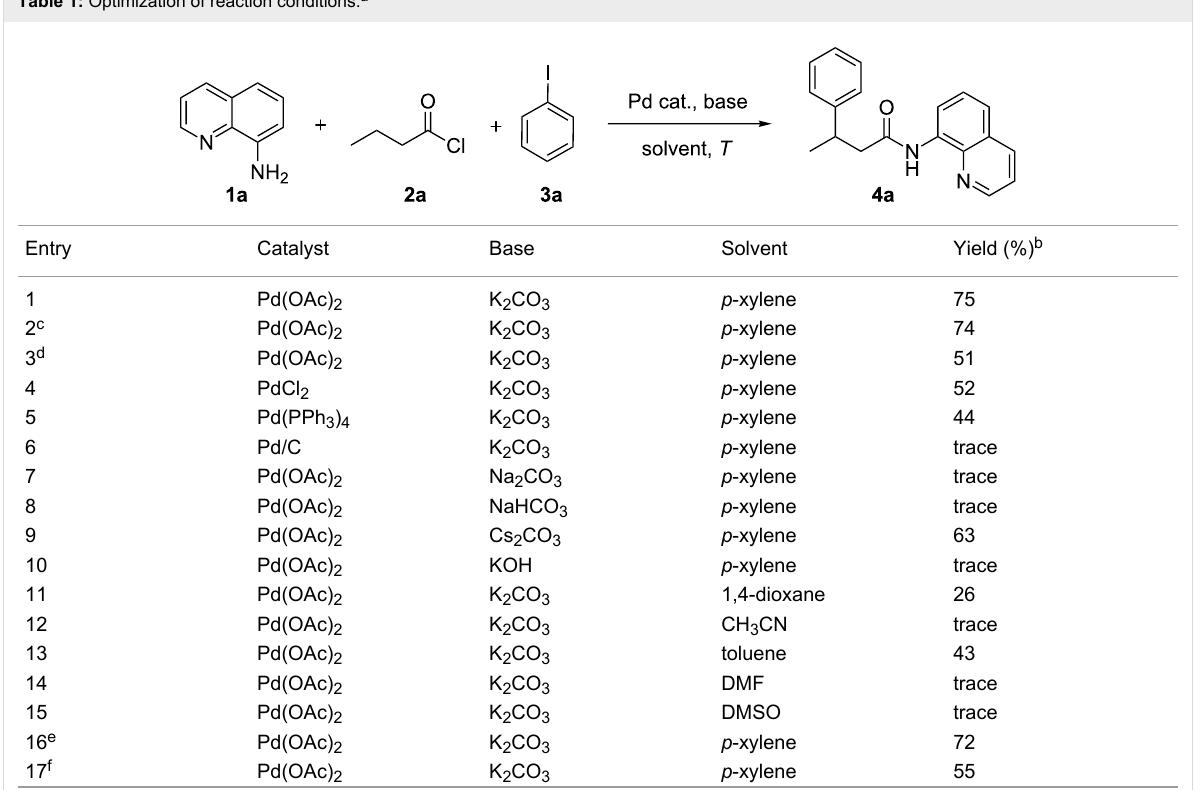
Table 1: Optimization of reaction conditions.